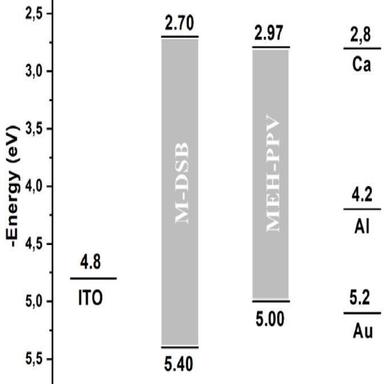
Energy level diagrams of ITO, M-DSB, MEH-PPV, PC71BM, Ca, Al and Au. with respect to the vacuum level.